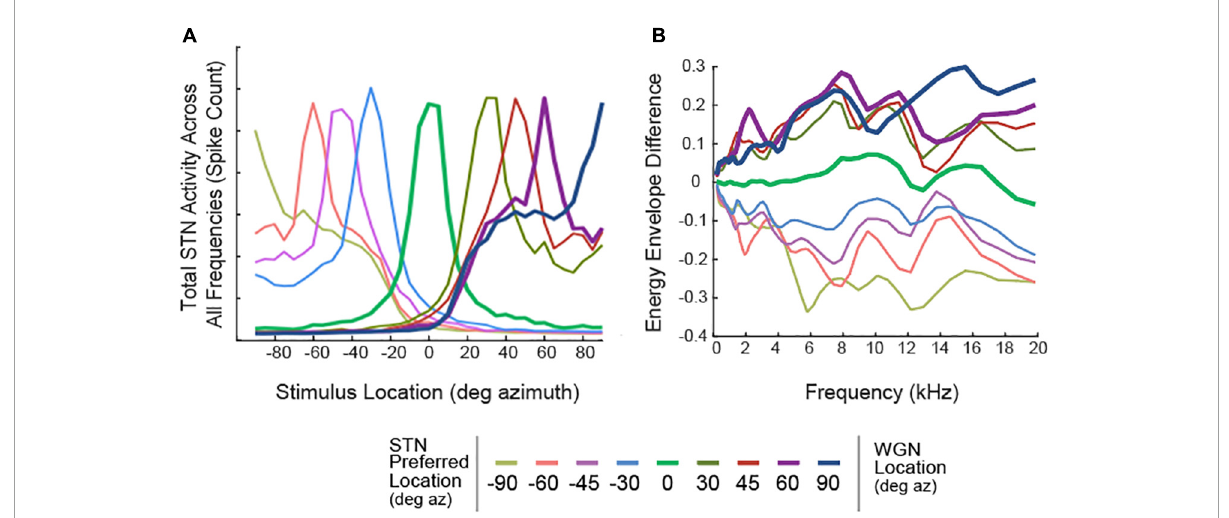
FIGURE2 Spatial Tuning Characteristics of STNs. (A) Spatial Tuning Curves of STNs, represented as total neural activity in response to a White Gaussian Noise (WGN). Each colored line represents the total response from a set of STNs. Tuning curves of STNs tuned to 0 ◦ , 60 ◦ , and 90 ◦ azimuth are bolded. (B) Preferred ILDs of STNs, calculated using WGNs placed at various locations along the azimuthal